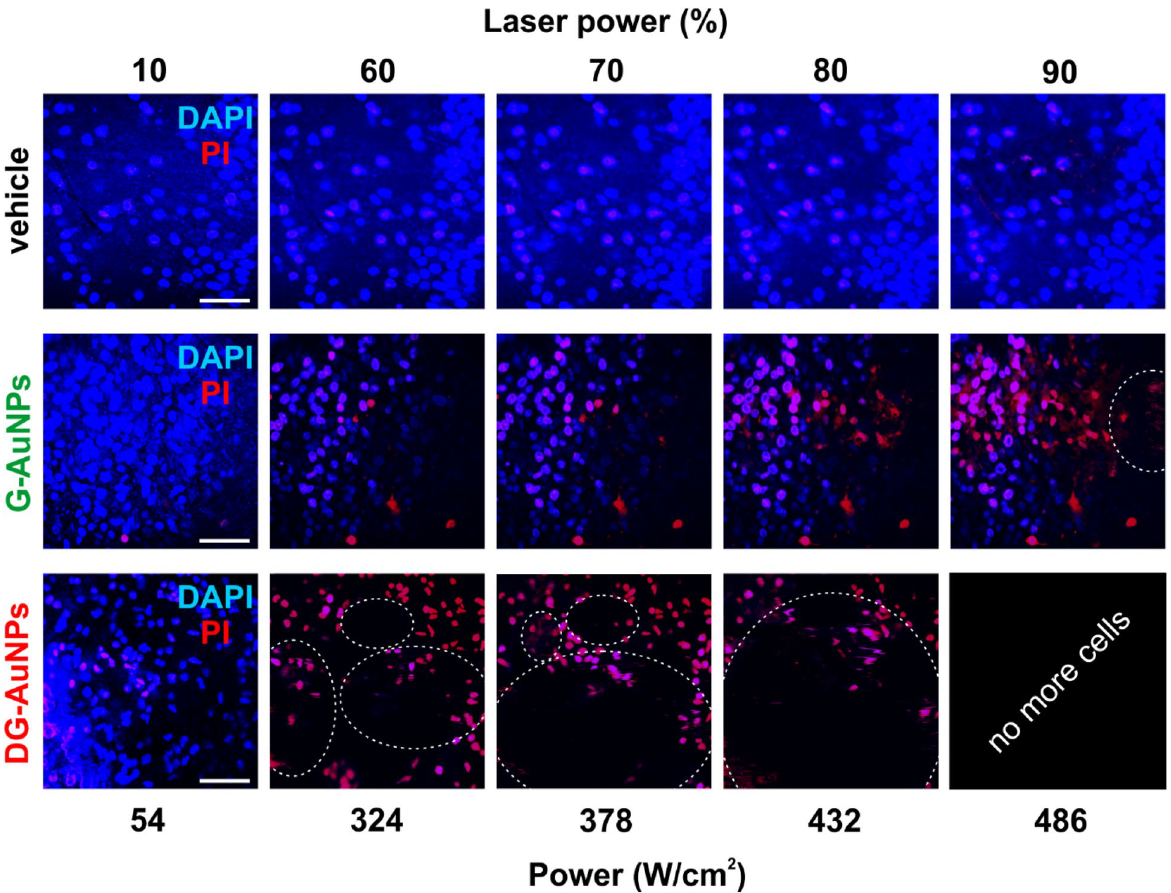
Figure 7. Organotypic brain slices (350-µm thick) treated for 1 h with the vehicles, G-AuNPs and DG-AuNPs (0.7 mg/mL) and irradiated with pulsed laser tuned at 760 nm at various power. DAPI was used to identify cell nuclei, and PI for cell death. Dotted circles represent heat-formed bubbles generated soon after irradiation. Scale bar: 50